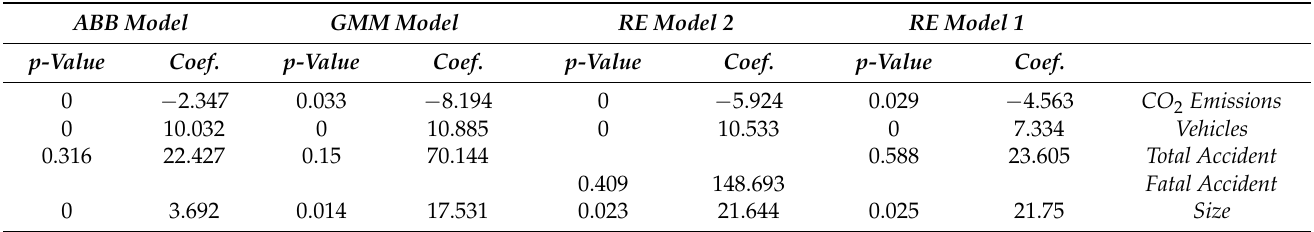
Table 7. The results of the effect of CO 2 emissions on the market value of automobile